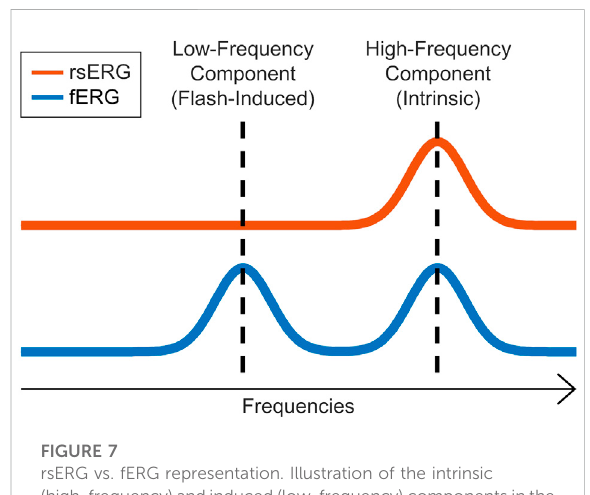
FIGURE 7 rsERG vs. fERG representation. Illustration of the intrinsic (high-frequency) andinduced(low-frequency) components inthe fERG and